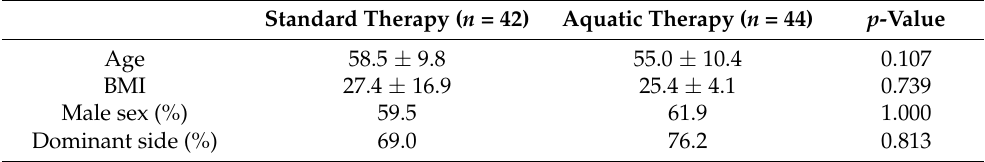
Figure 2. Consort flow diagram. Table 1. Demographic